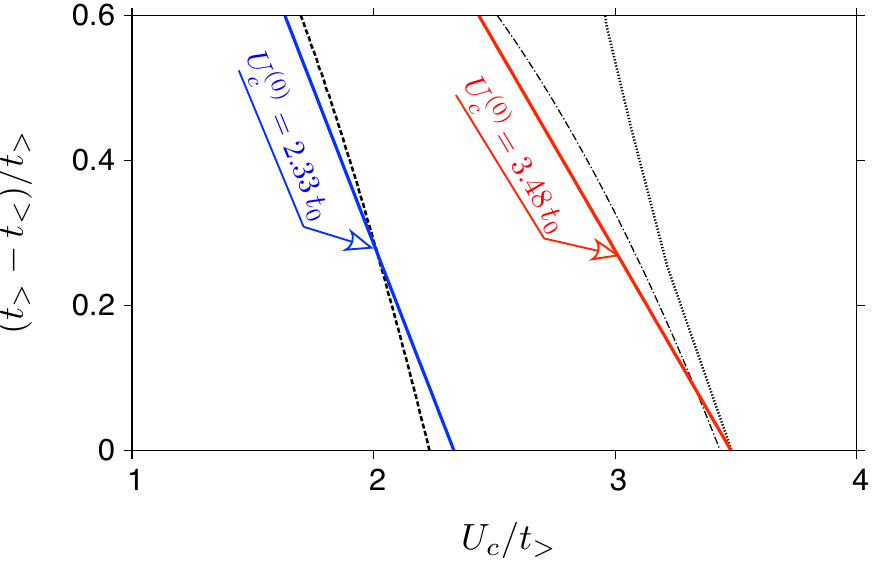
Figure 6. The evolution of critical Hubbard interaction with armchair strain strain ( t y (cid:54) t x ), approximated by Equation (26) [solid lines] for two values of U ( 0 ) c (specified on the plot) adjusted to match the zero-strain results obtained from HF and GWF methods. The remaining lines are the same as in Figure